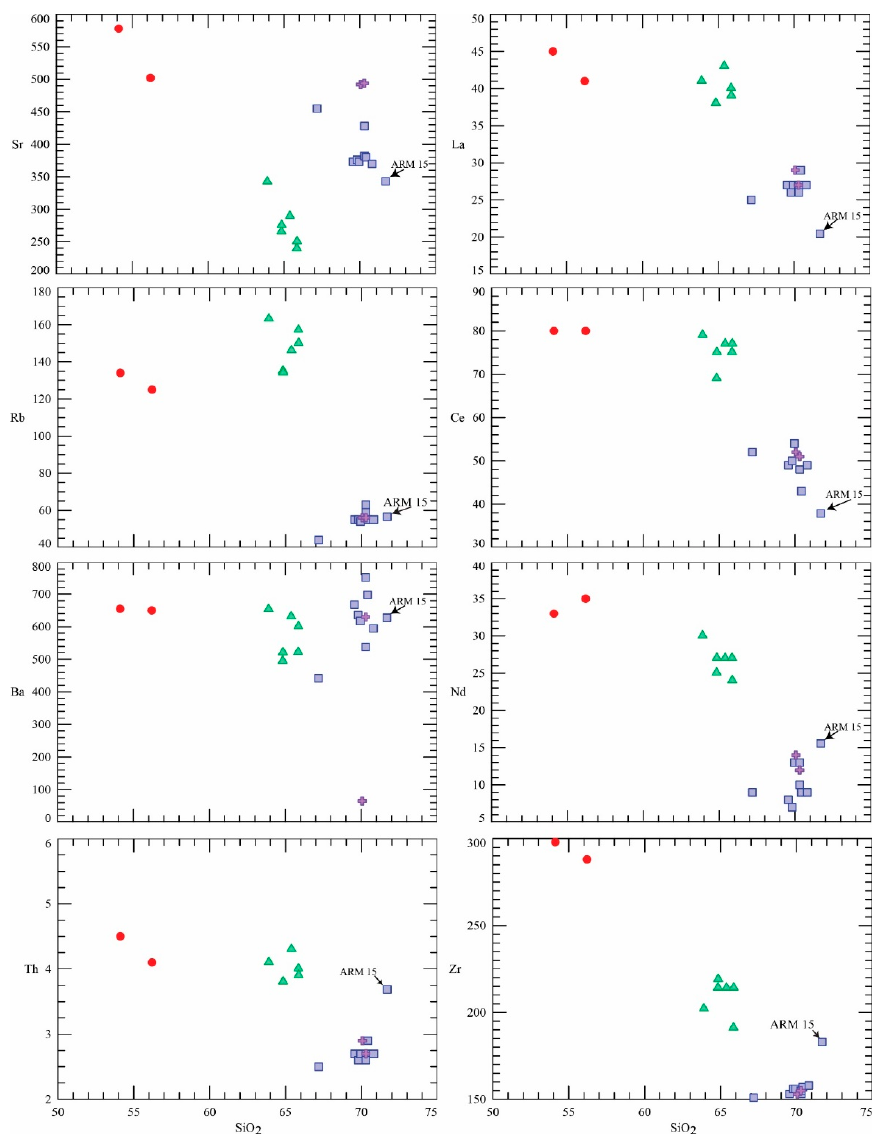
Figure 10. Diagram of the variation of some trace elements versus SiO 2 . See symbol legend in Figure 8.